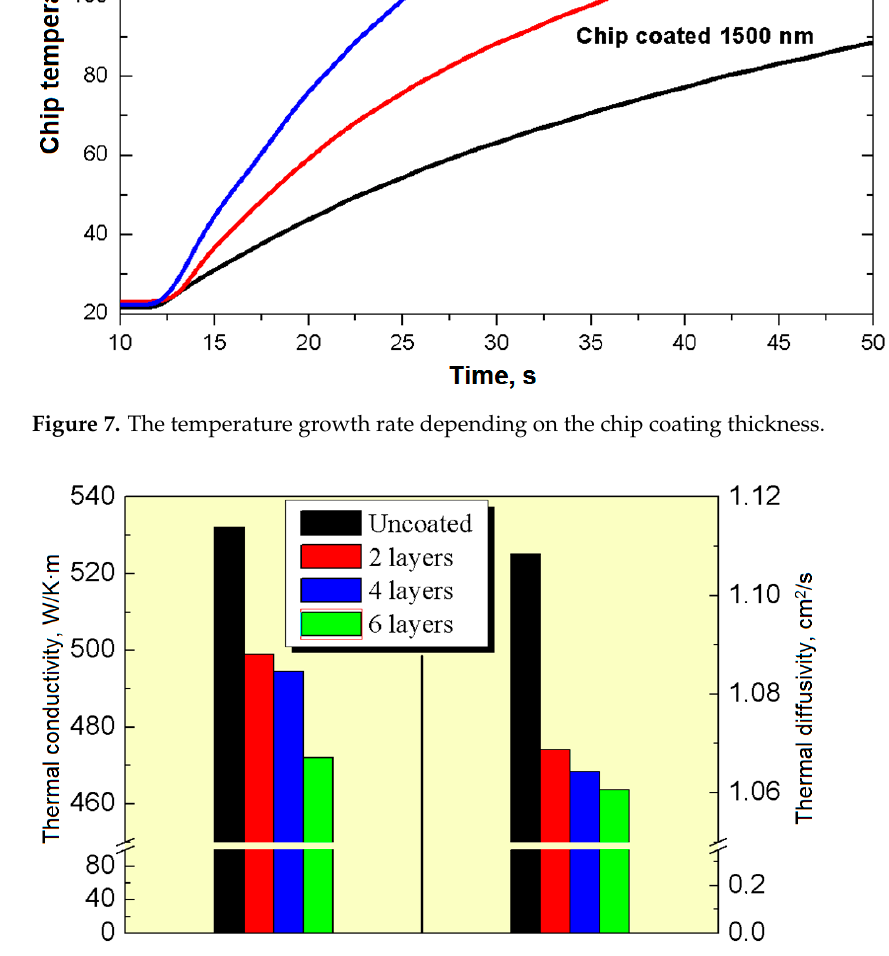
Figure 8. Thermal diffusivity and thermal conductivity of the obtained coatings based on alumi- num oxide and aluminum nitride ceramics. Each two layers mean the combination of Al 2 O 3 and AlN.